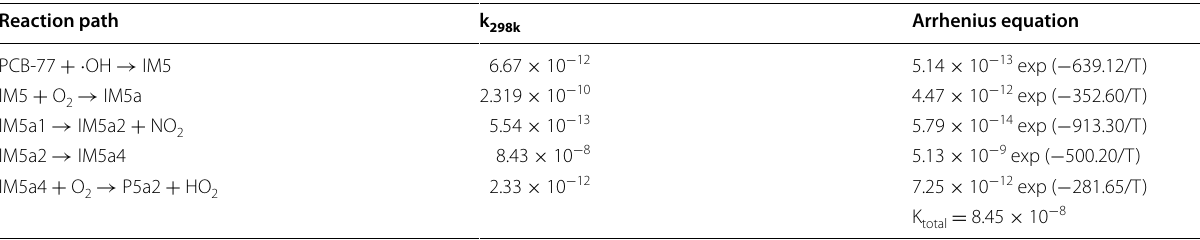
Table 4 The degradation rates (k, cm 3 /molecule s) for pathway A at 298 K and standard atmospheric pressure, and the Arrhenius equation at 238–357 K (gas phase)